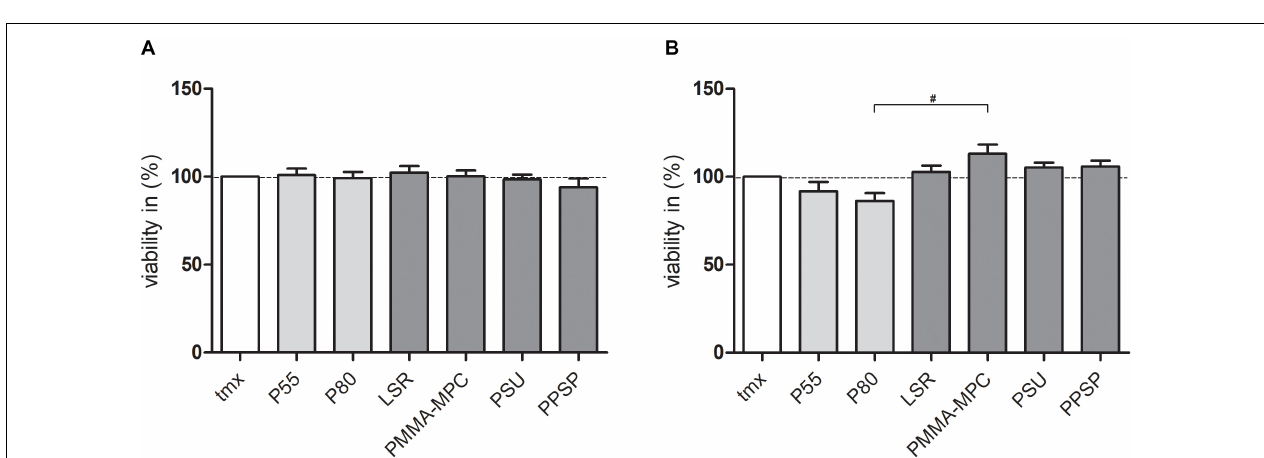
FIGURE 3 | LSR coated with polymethylmethacrylate-2-methacryloyloxyethyl phosphorylcholine (PMMA-MPC) suppresses S. aureus colonialization. Materials were incubated with 1 × 10 8 CFUs of (A) S. aureus and (B) S. epidermidis and bacterial viability was quantified after 1 h by WST assay. Values were normalized to tmx control (100%). Data are represented as mean + SE Mean of three independent experiments carried out in duplicates. Significances: # vs. PMMA-MPC: # p <